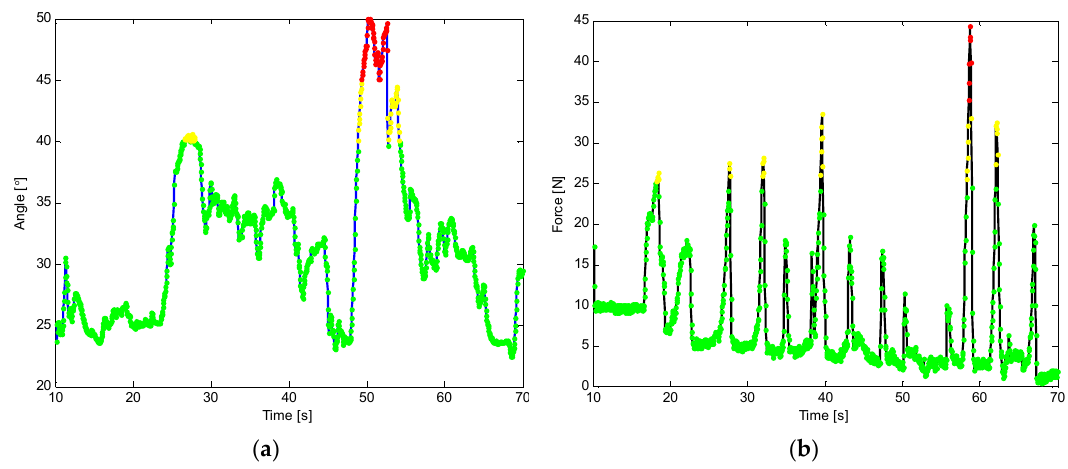
Figure 13. Scenario for the third sequence of experiments.